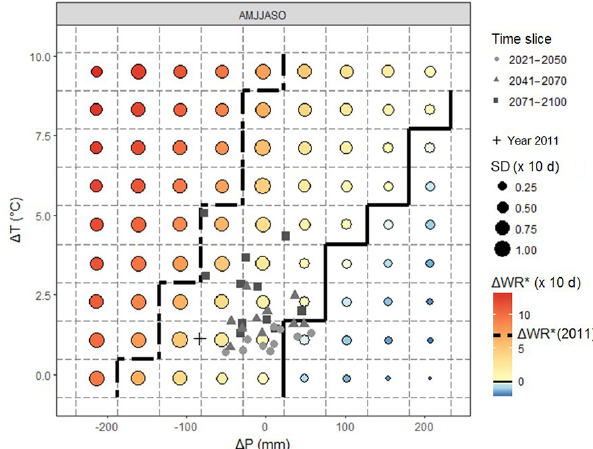
Figure 12. Climate response surface of legally binding water- restriction-level anomalies (cid:49) WR ∗ for the Ouche river basin, includ- ing both exposure and performance